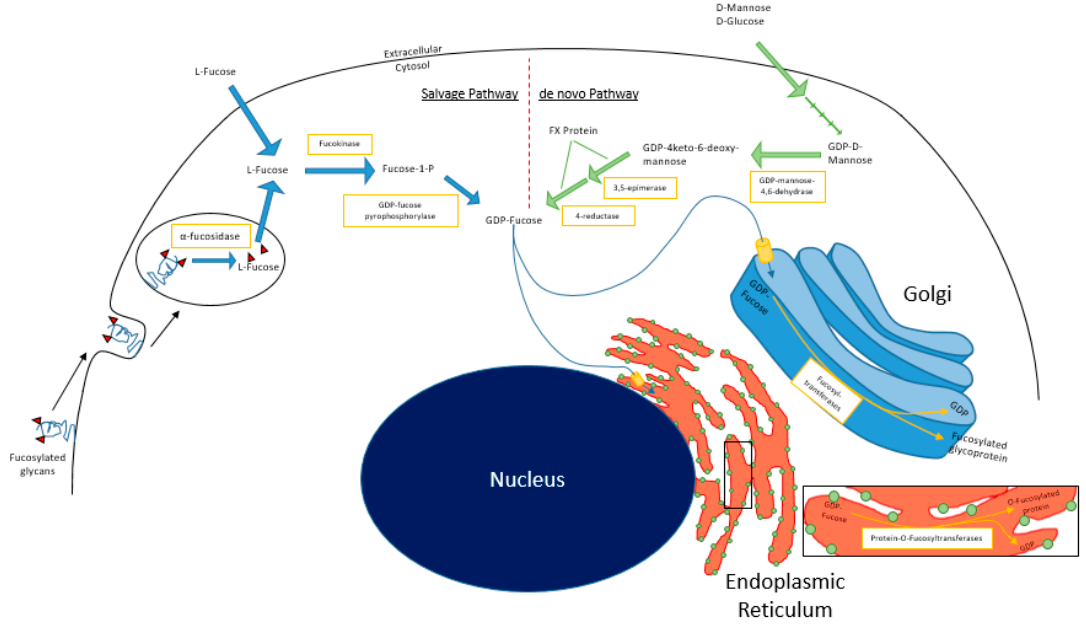
Figure 1. Fucose salvage and de novo pathways.